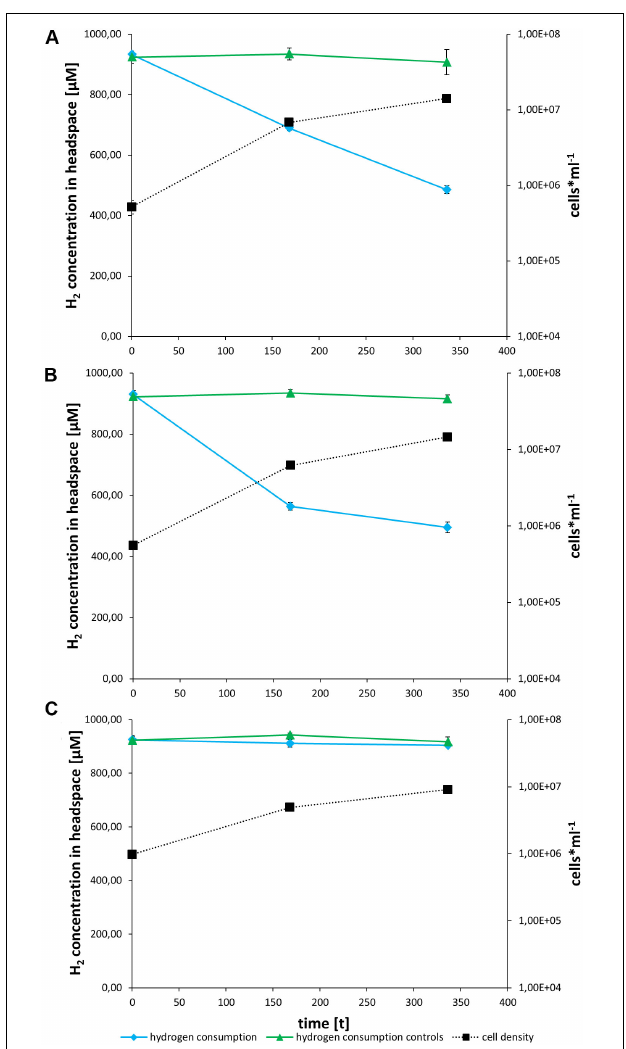
FIGURE 3 | In vivo hydrogen consumption and growth of the T-ASW enrichment culture on MJ (A) , MJ-T (B) and T-ASW (C) medium. Hydrogen consumption of the cultures is shown in blue with diamonds, controls containing only the respective medium in green with triangles and cell number of the cultures as dotted line in black with squares. The experiments were performed in triplicate, followed by polymerase chain reaction and sequencing of 16S rRNA and hynL genes (Hansen and Perner, 2015). Hydrogen consumption was determined by using gas chromatography and cell numbers were detected as described before (Hansen and Perner, 2015).